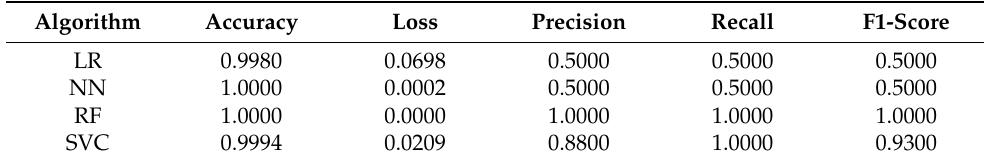
Table 3. Algorithms’ results using the imbalanced dataset as